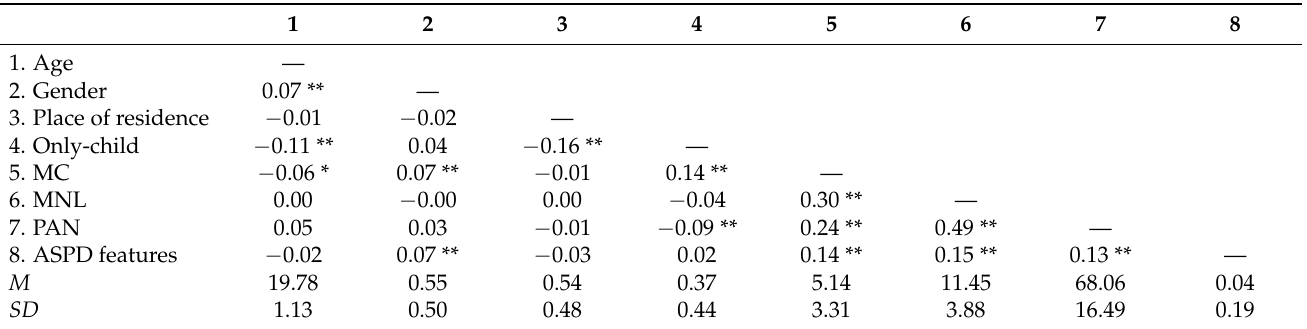
Table 1. Means, standard deviations and correlations of the study variables.